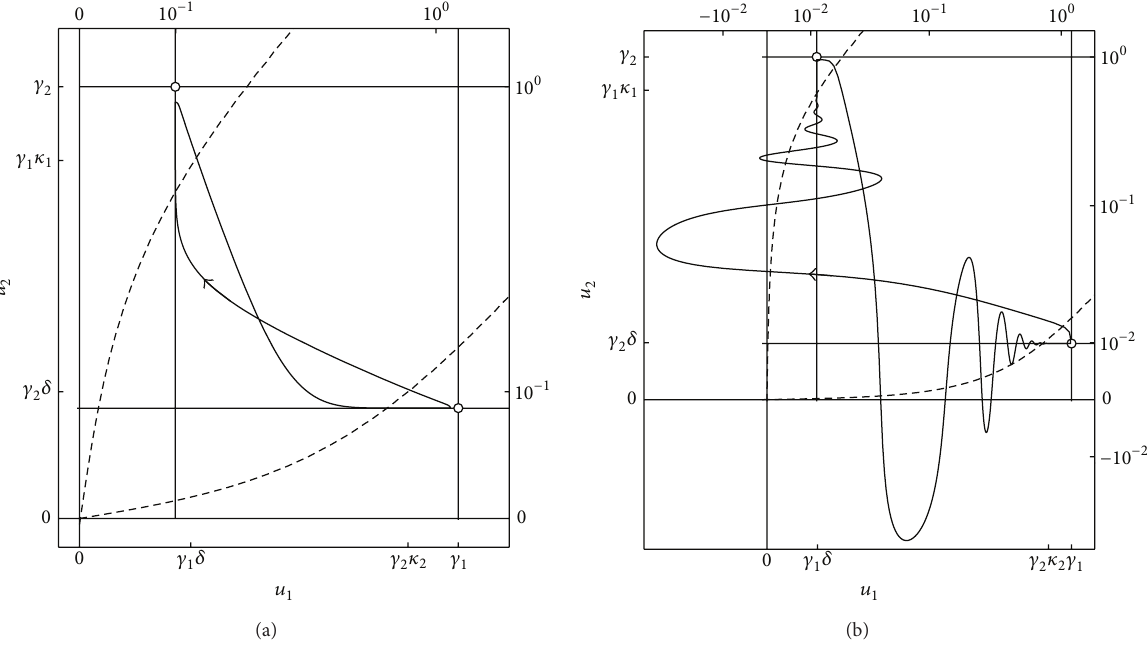
Figure 6: The limit cycle of system (1a)–(1d) projected onto phase plane of the slow variables in the cases of (a) strong second-order damping, and (b) underdamping. The parameters of the model chosen for numerical simulation are 𝜀 = 0.727273×10 −3 , 𝛾 1 = 1.19375 , 𝛾 2 = 1 , 𝜘 1 = 0.5 , = 0.8 , 𝛿 = 0.1 (a), and 𝛿 = 0.01 (b). 𝜘 2